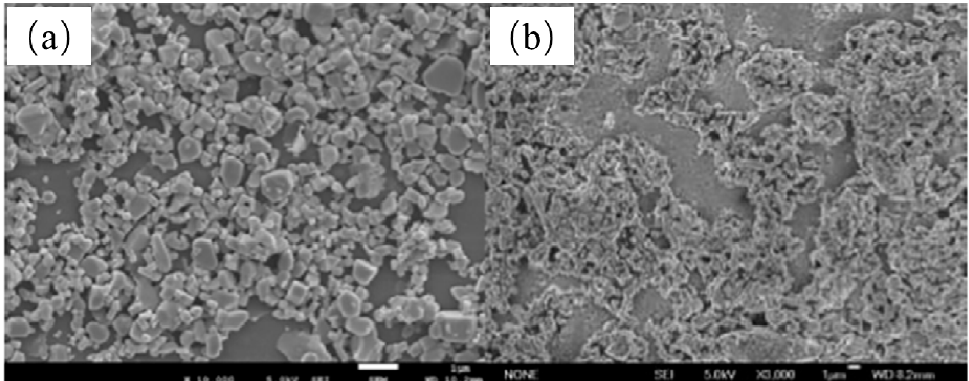
Figure 3. SEM picture of the sample obtained using green mixture with packing density of 0.66 g/cm 3 ( a ) and 1.32 g/cm 3 ( b ) [64].